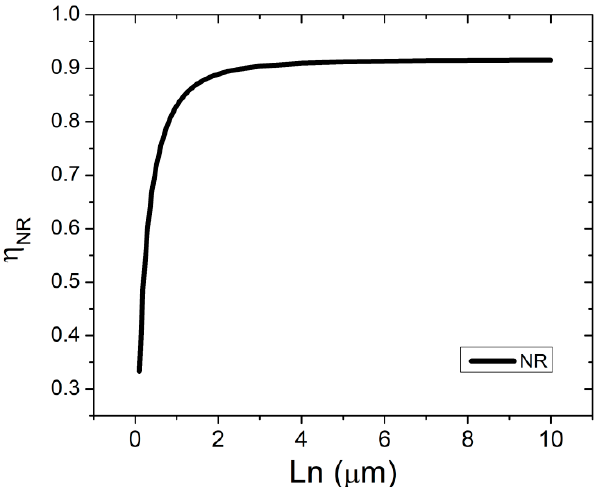
Figure 5. The dependence of neutral region photo-carrier collection coefficient on CdTe’s diffusion length L n .